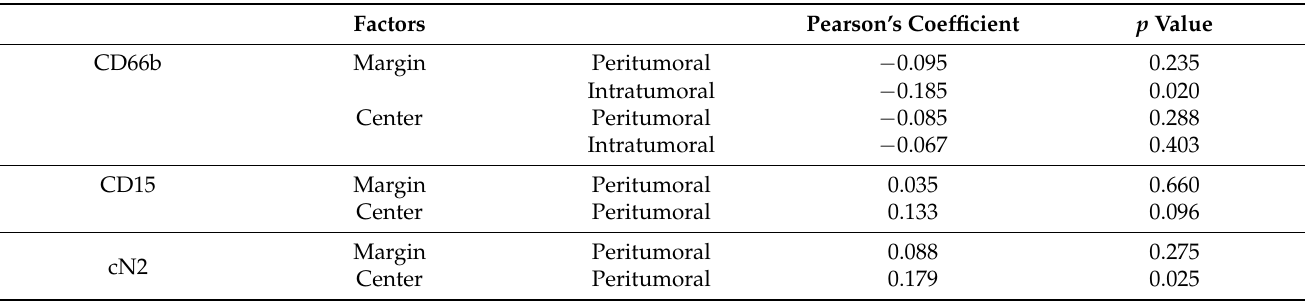
Table 4. Correlation of variable tumor associated neutrophils, calculated tumor-associated neutrophils for pro-tumor function, and tumor—stromal